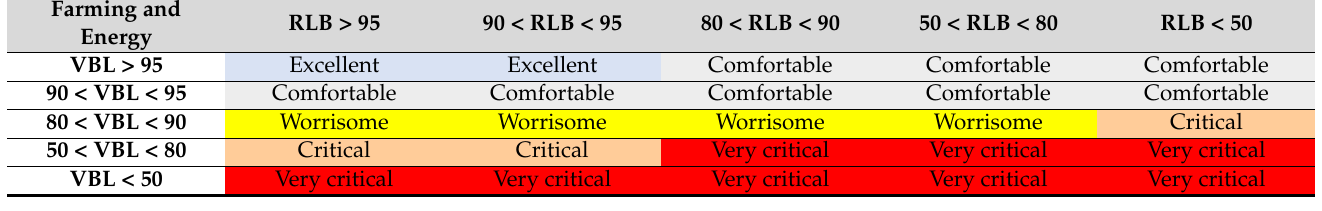
Table 3. Classification—farming and energy.